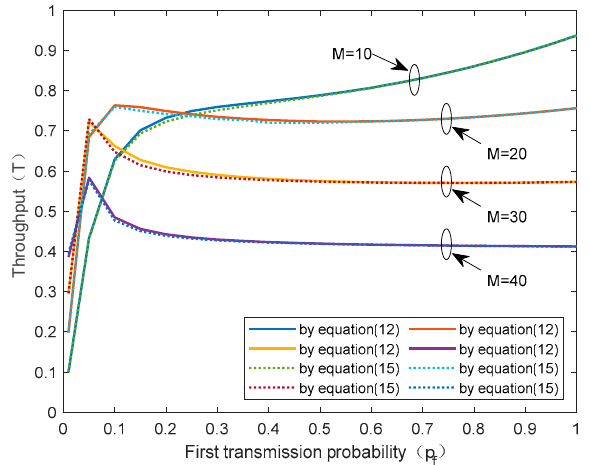
Figure 8. Throughput vs. first transmission probability (Equation (12) vs. Equation (15)).